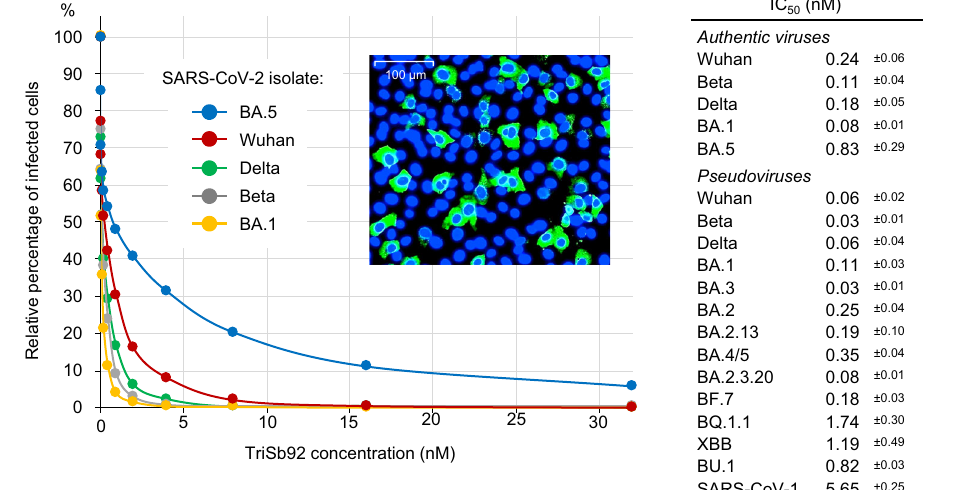
Fig. 2 | Neutralization ofSARS-CoV-2 and SARS-CoV-1 by TriSb92. Half-maximal inhibitory concentration (IC 50 ) of TriSb92 against different authentic SARS-CoV-2 variants or pseudoviruses using the indicated spike proteins were established based on automated counting of fl uorescently labelled infected cells (see fi gure insert) or luciferase reporter gene expression, respectively. Standard deviation for the calculated IC 50 values is shown. The pseudovirus neutralization experiments wererepeatedindependentlythreeormoretimeswithsimilarresults.Averageand